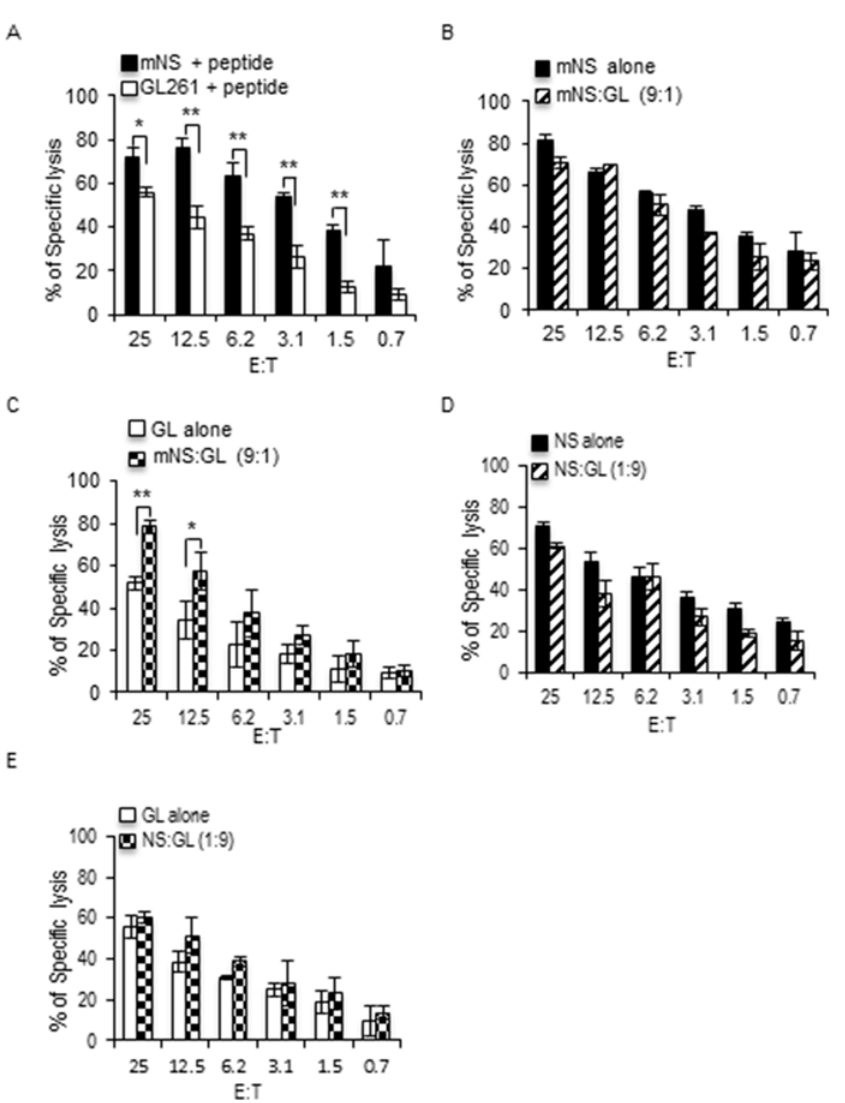
Fig 4. GSC enhance the killing of GDC by day 9 PMEL CTL. (A) GL261 and mNS were loaded with calcein AM and calcein Red Orange respectively, then pulsed with peptide and mixed in 1:1 ratio before simultaneous incubation with day 9 PMEL CTL in a dual color cytotoxicity assay. The cytotoxicity toward each target is followed by measuring the release of the respective calcein in the supernatant. (B) Peptide- pulsed mNS cells alone were used as target for day 9 PMEL CTL in a classical calcein AM release assay (mNS alone), while on the other side peptide-pulsed mNS were mixed in 9:1 ratio with peptide-pulsed GL261 (mNS:GL 9:1) and incubated simultaneously with day 9 PMEL CTL in a dual color cytotoxicity assay. (C) The killing of GL261 facing CTL alone compared with the killing of GL261 in mNS:GL ratio of 9:1 obtained from B. (D) Same as in B for an mNS:GL ratio of 1:9. (E) Same as in C for mNS:GL ratio of 1:9. All bar graphs are mean +/- SD of three independent experiments. P value * p (cid:3) 0.05, ** p (cid:3) 0.01, one-sided